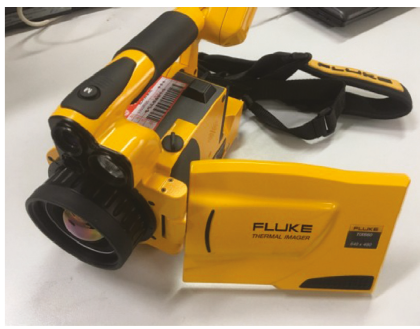
Figure 4: Infrared camera.